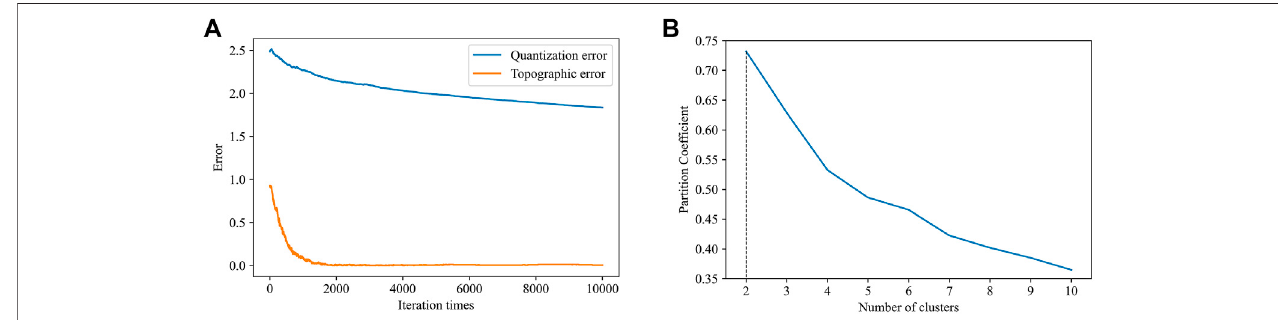
FIGURE 6 | Visualization of the SOM. The fi rst 11 graphs show the indicators. The last graph displays the U-matrix.